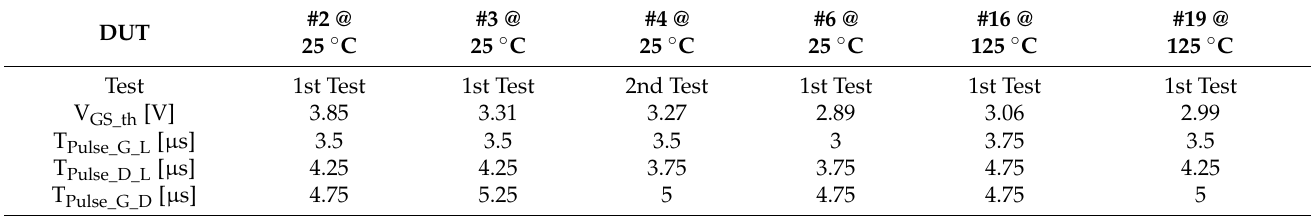
Table 1. Different key parameters of several